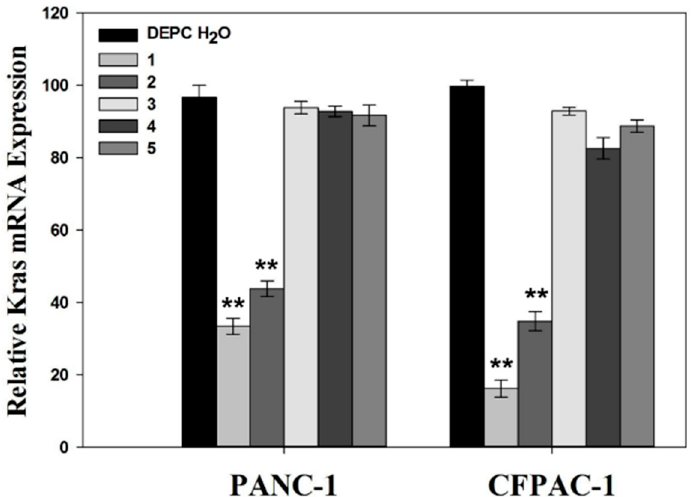
Figure 7. Expression of Kras mRNA in PANC-1 and CFPAC-1 cells after treatment by (1) siRNA- Mate/siKras, (2) HAp-PEI/siKras, (3) siKras, (4) HAp-PEI, and (5) HAp/siKras for 48 h. DECP H 2 O was used as control. Values are represented as mean ± SD (n = 3). Statistical significance relative to the group of control: ** p < 0.01.